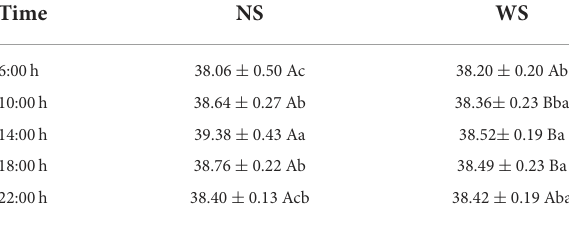
Average AB followed by distinct capital letters, in the same line, are different (P < 0.05). Average ab followed by distinct lower case letters, in the same column, are different(P <